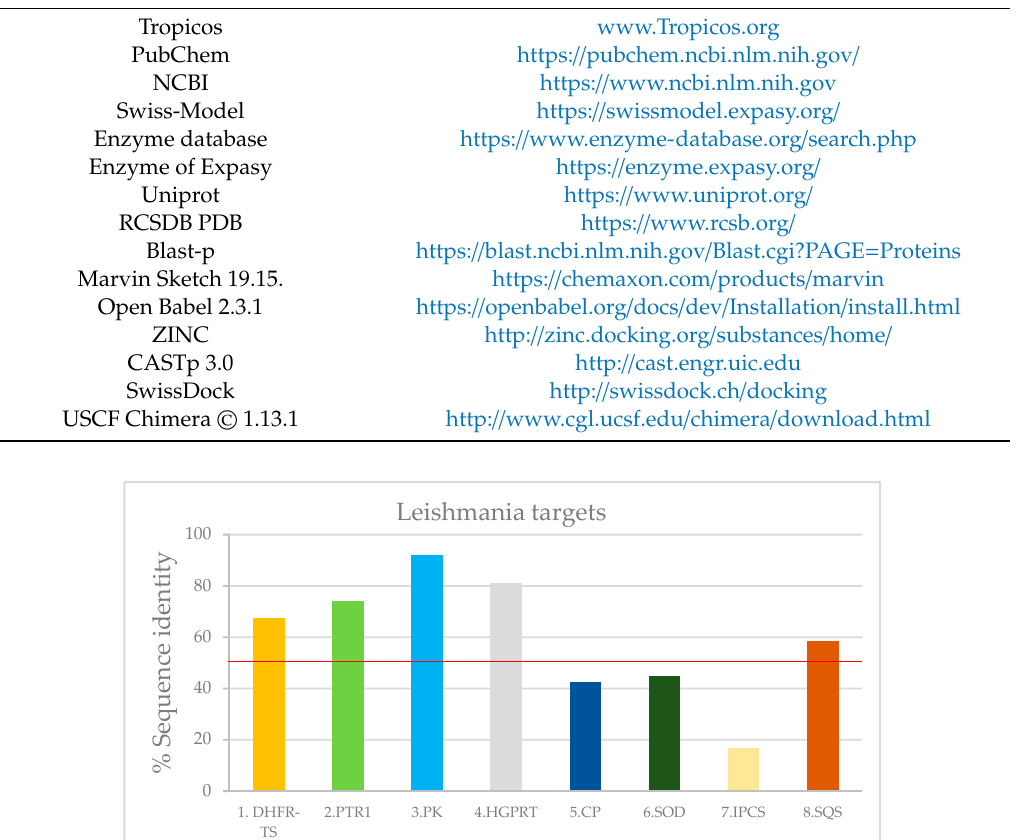
Table A5. URL of programs and database available, free access online.